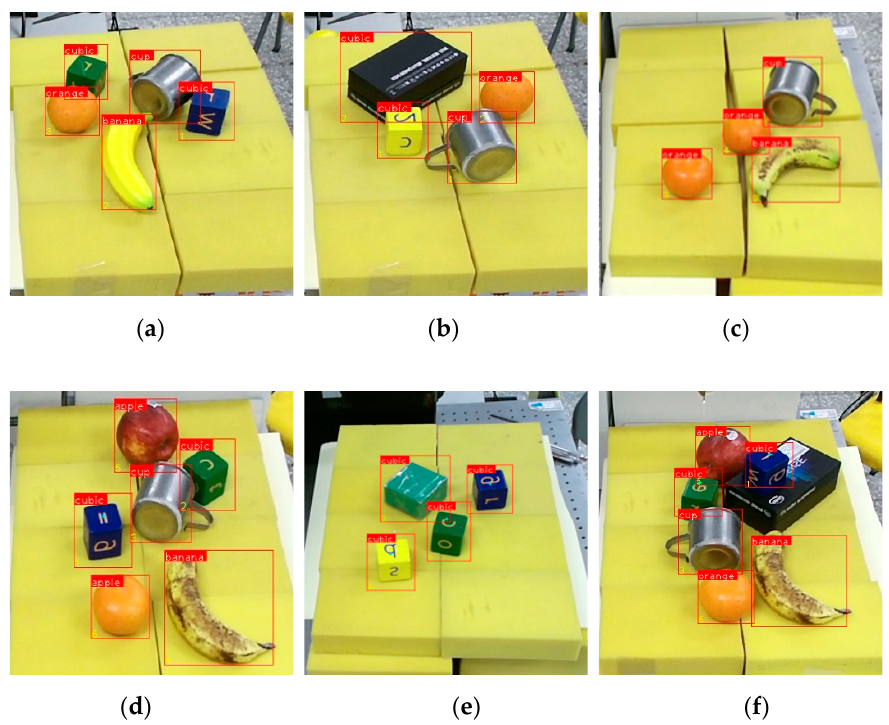
Figure 11. Detection/classification results of YOLOv3 after training ( a ) 1st test ( b ) 2nd test ( c ) 3rd test ( d ) 4th test ( e ) 5th test ( f ) 6th test.